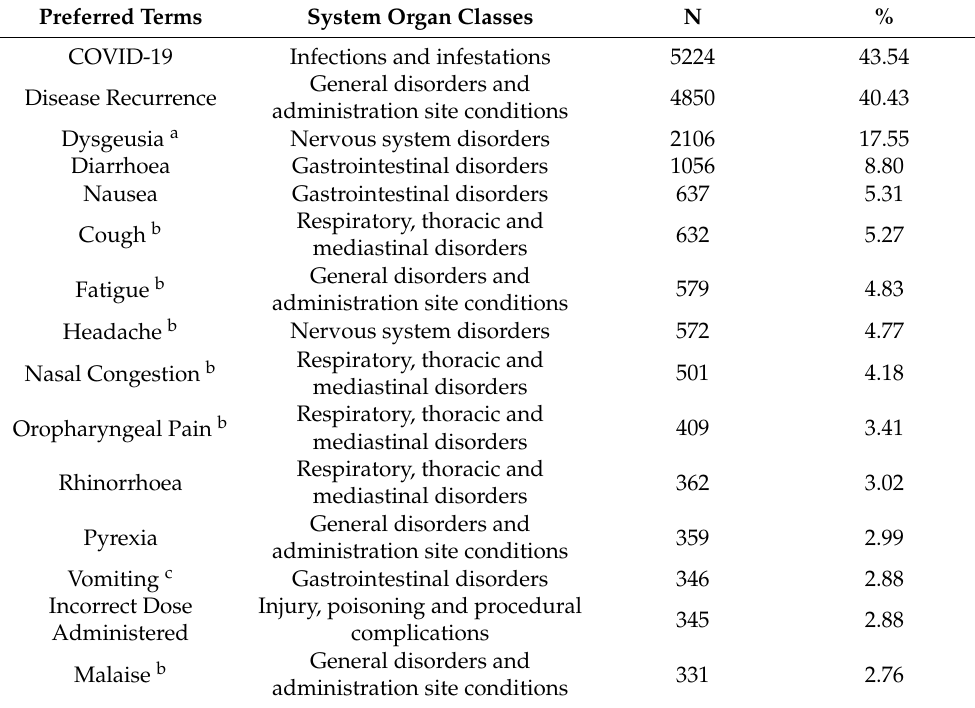
Table 3. Common adverse events reported to FAERS with nirmatrelvir/ritonavir as a suspected drug.